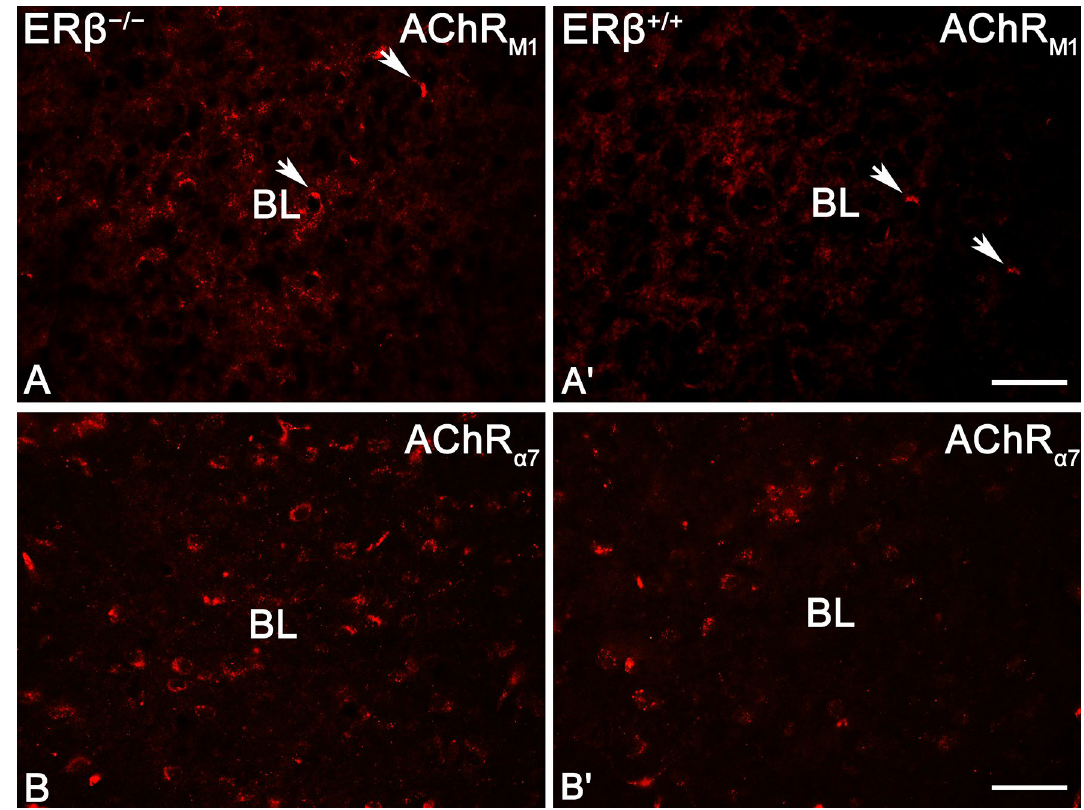
Figure 8. Representative colour photomicrographs illustrating the staining patterns of muscarinic acetylcholine type 1 receptor (AChR M1 ) and alpha-7 nicotinic acetylcholine receptor (AChR α7 ) in the amygdala basolateral nucleus (BL) of ERβ knock-out (ERβ −/− ) and wild-type (ERβ +/+ ) mice, n = 6 per group. ( A , B ) ERβ −/− mice. ( A ′ , B ′ ) ERβ +/+ mice. Note increased density of AChR M1 and AChR α7 in ERβ −/− mice ( A , B ) when compared to ERβ +/+ littermates ( A ′ , B ′ ). Note also strong neuropil staining in AChR M1 preparations ( A , A ′ ) which makes it difficult to discern cells (arrows) from the background. The scale bar applies to all microphotographs, and it corresponds to the length of 50 µm.